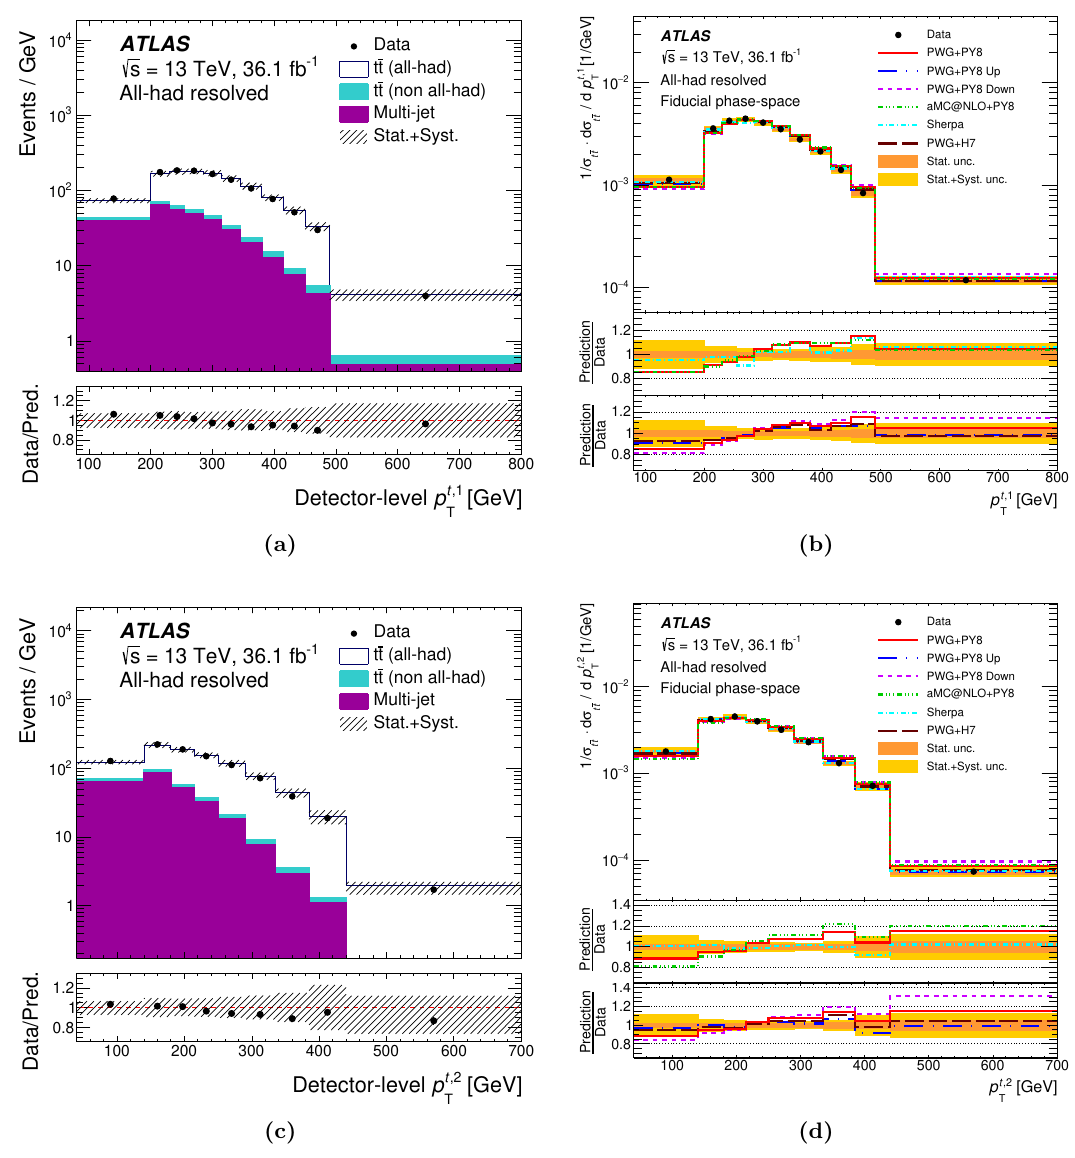
Figure 5 . Comparison of the ATLAS data with the fully simulated nominal SM predictions for the (a) leading and (c) sub-leading top-quark transverse momenta. The shaded bands represent the uncertainties in the total prediction. Data points are placed at the centre of each bin. The lower panel shows the ratios of the data to theoretical predictions. Single-differential normalised cross-section measurements, unfolded at particle level, as a function of the (b) leading and (d) sub-leading top-quark transverse momenta. Overflow events are included in the last bin of every distribution shown. The unfolded data are compared with theoretical predictions. In the top panel, the unfolded data are shown as black points, while lines indicate the predictions from several MC programs. Uncertainties are shown by the shaded bands. Data points are placed at the centre of each bin. The lower two panels show the ratio of the MC predictions to the unfolded